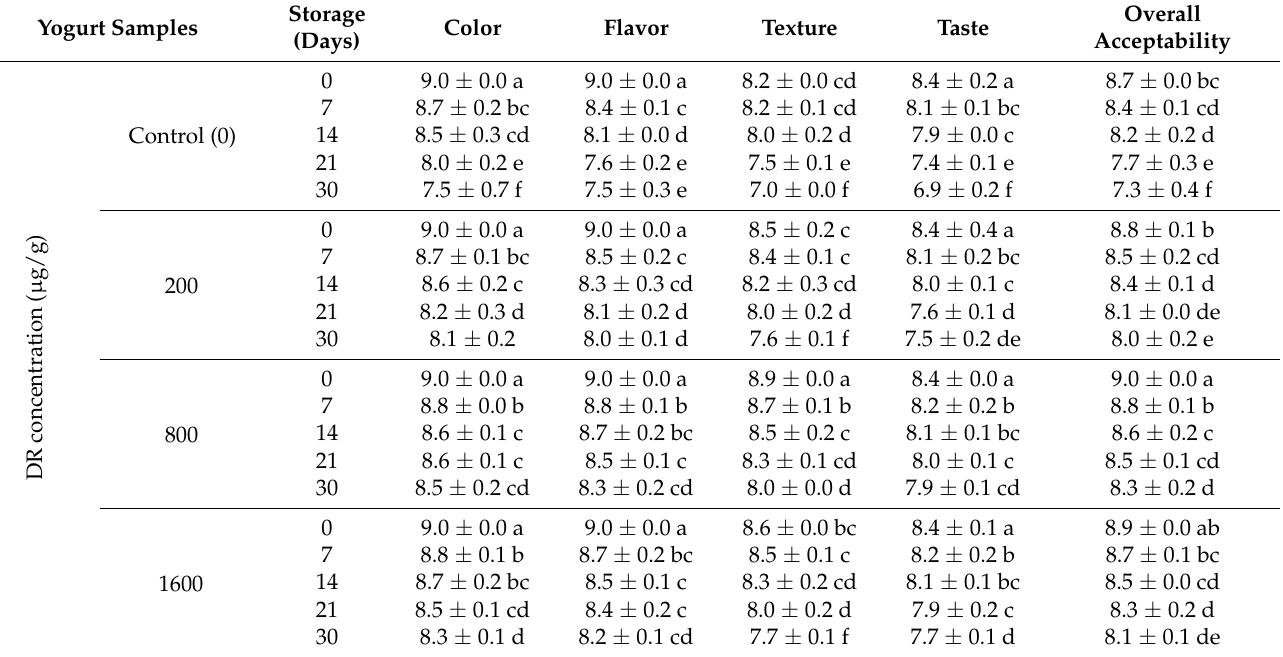
Table 4. Sensorial properties of DR strawberry beverages (200, 800, and 1600 µ g/g) during cold preservation (mean ±